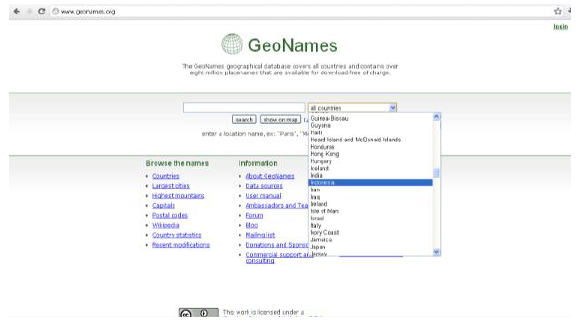
Figure 5. GeoNames website (geonames.org) provide gazetteer for the world